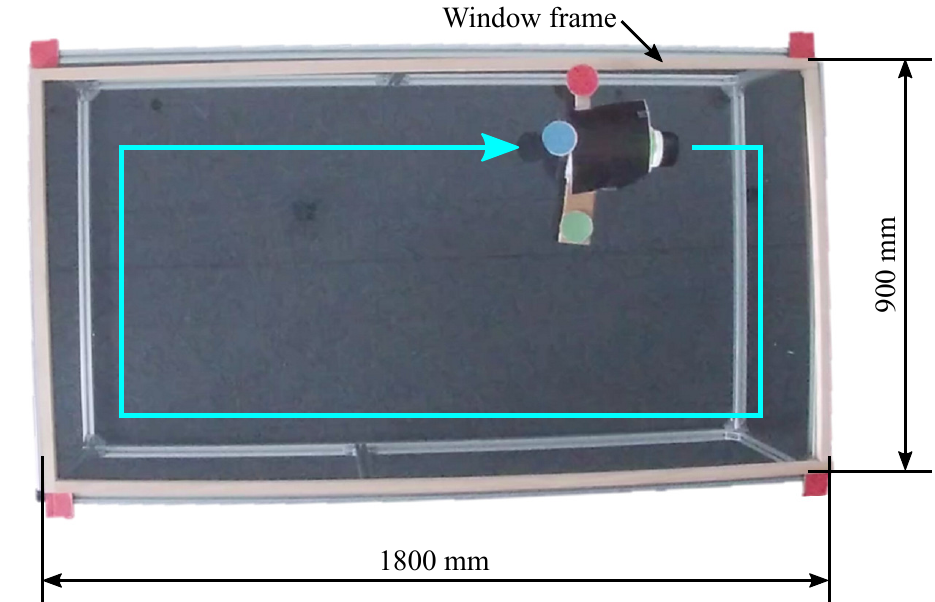
Figure 9. Experimental setup. In the experiments, the window scanning robot moves around the same trajectory along the frame of the rectangle window on its surface placed on the floor. Its size is 900 × 1800 mm.